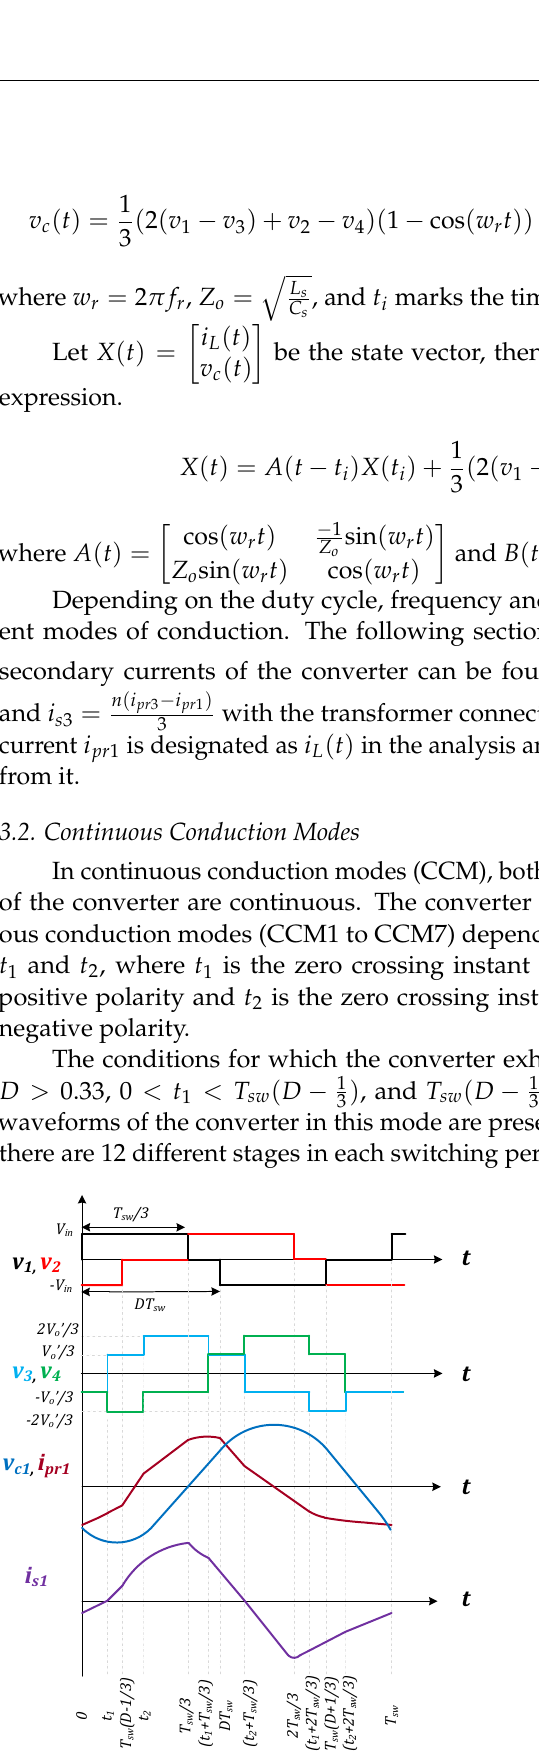
Figure 4. Converter waveforms in CCM1